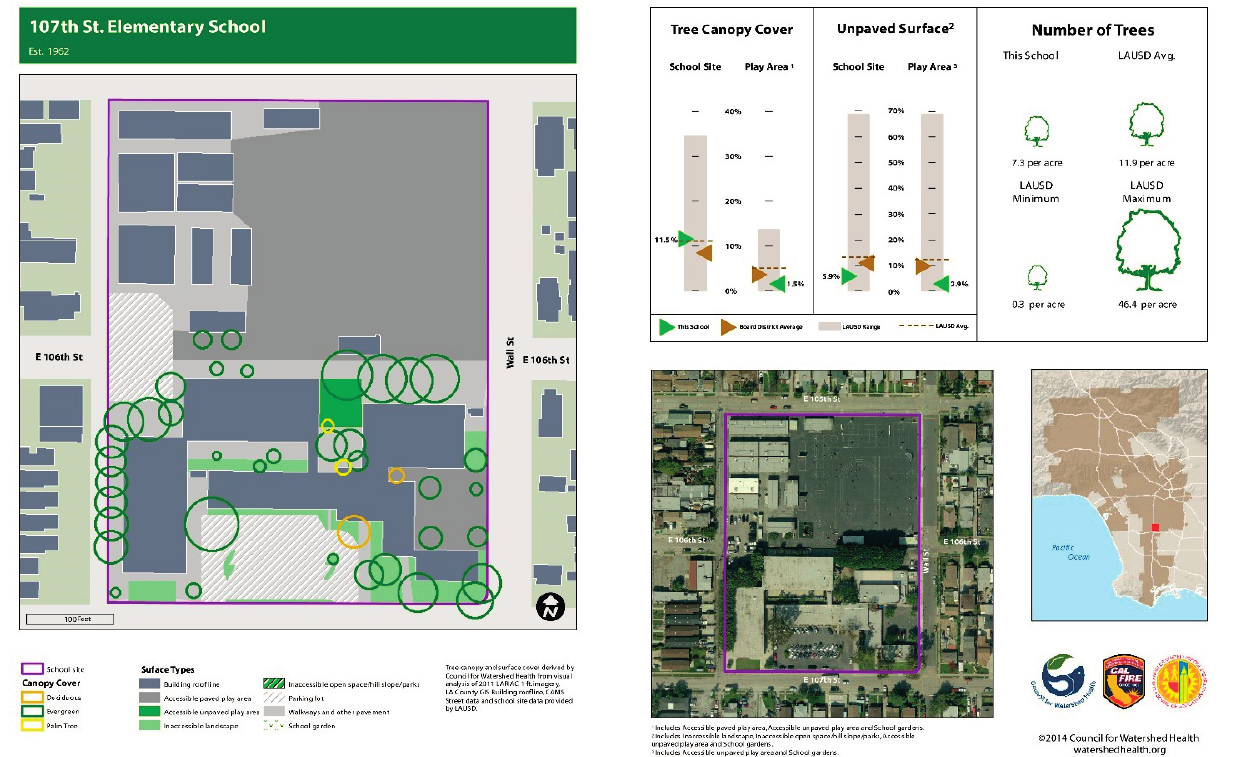
Figure 2. Example report for each school